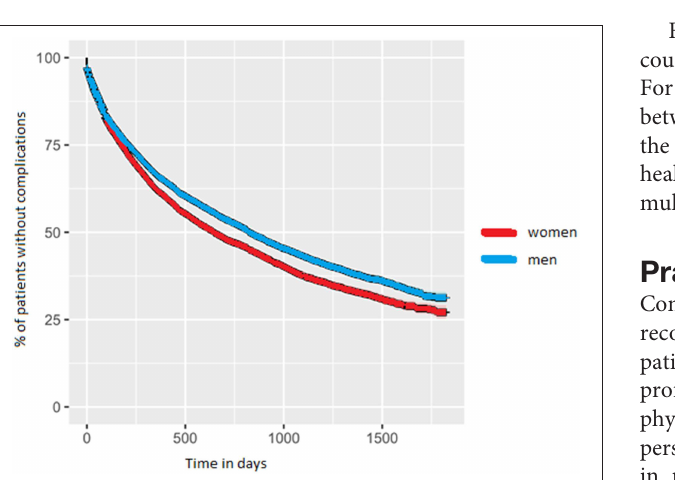
be explained by the female predominance in